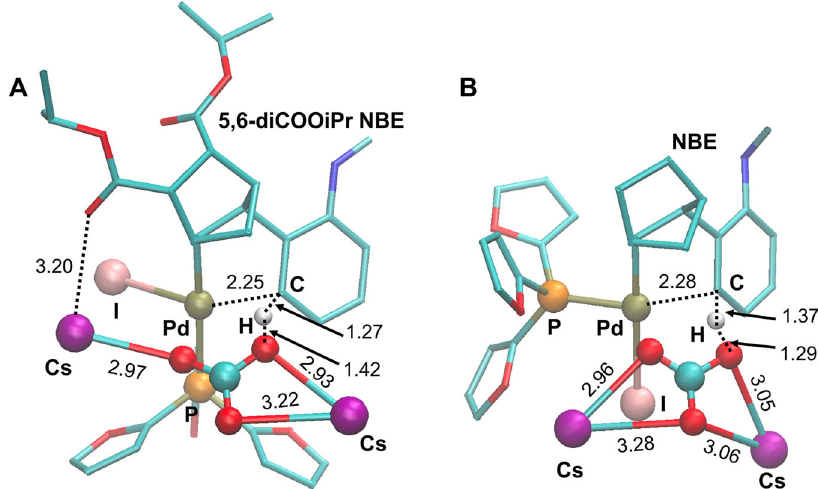
Fig. 10 Transition state structures TS1 and TS1(a). Transition state structures of the Cs 2 CO 3 -induced C-H activation through a concerted metalation – deprotonation process to result in II and II(a) . A With 5,6-diCOO i Pr NBE (barrier height 20.5 kcal/mol), where a coordination between Cs and carbonyl O was observed, and B With the unsubstituted NBE (barrier height 22.6 kcal/mol). Different orientations of TFP were